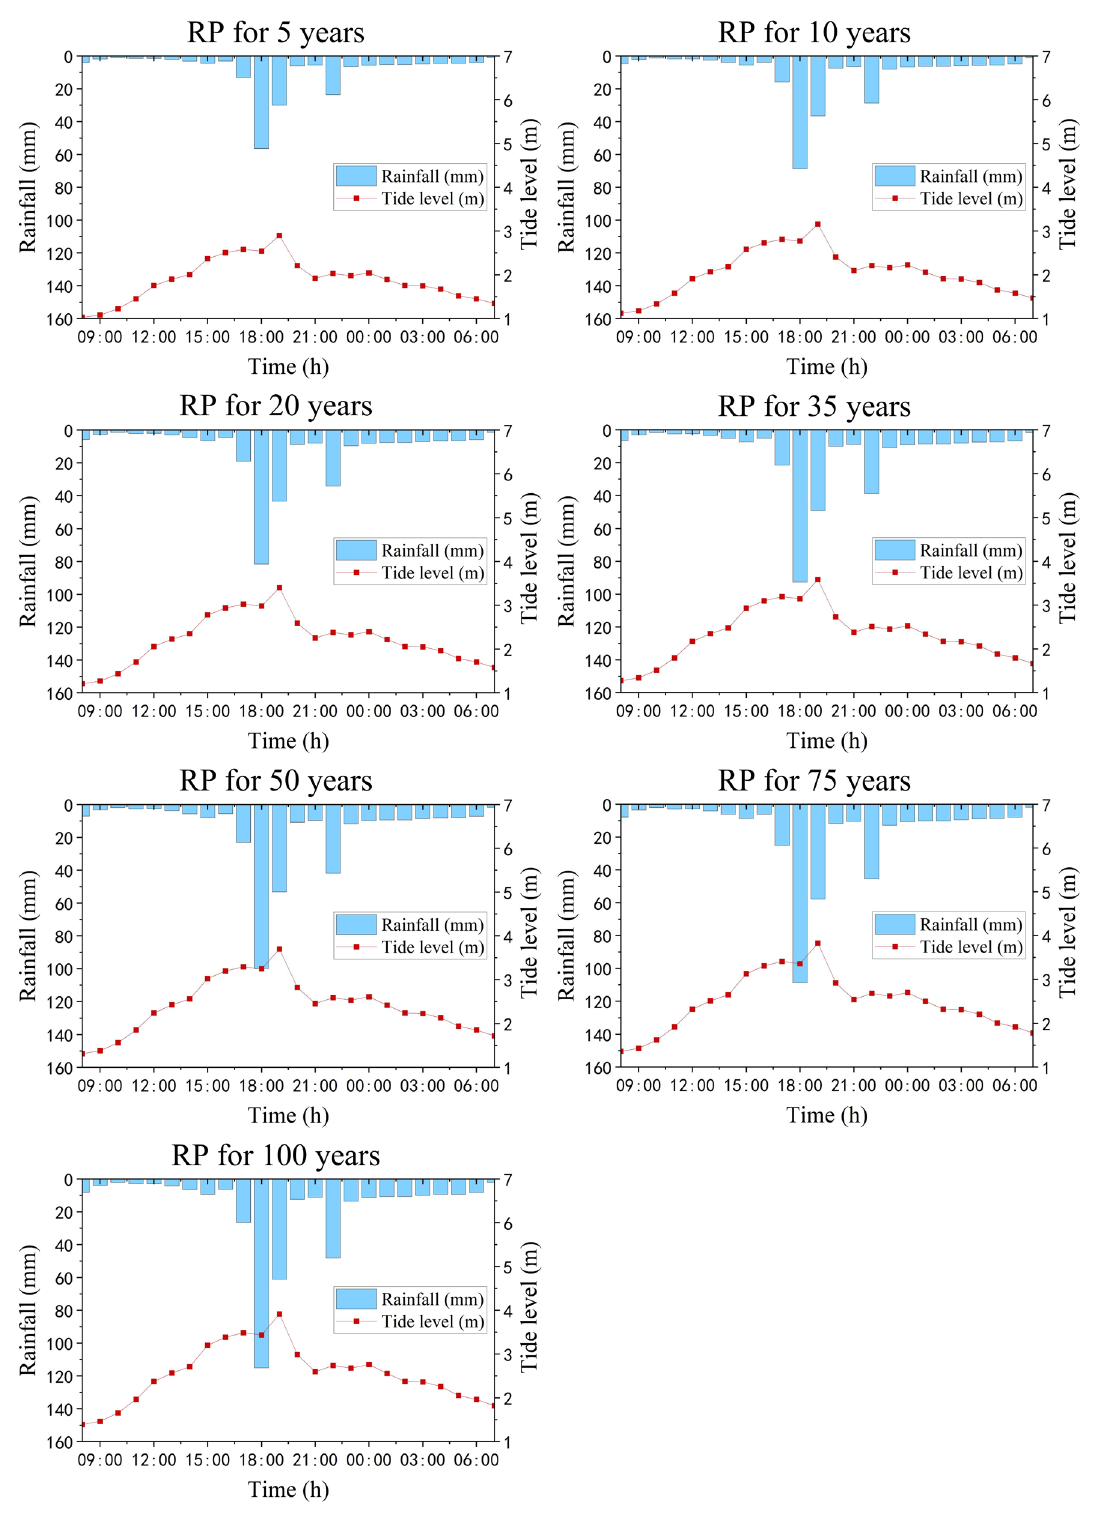
Fig. 6 Sequences of rainfall and tide levels for seven return periods on Haidian